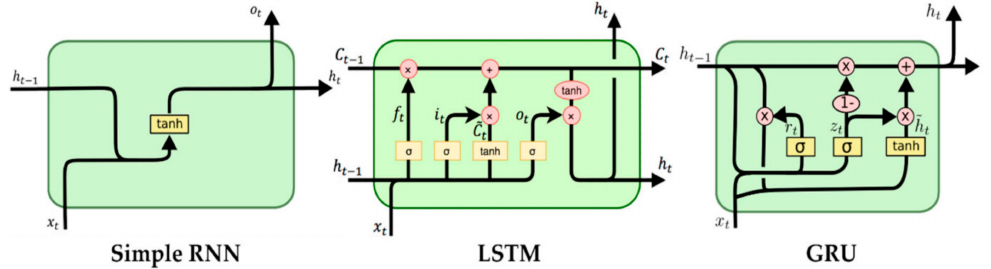
Figure 27. Schematics for the RNN, LSTM, and GRU machine learning